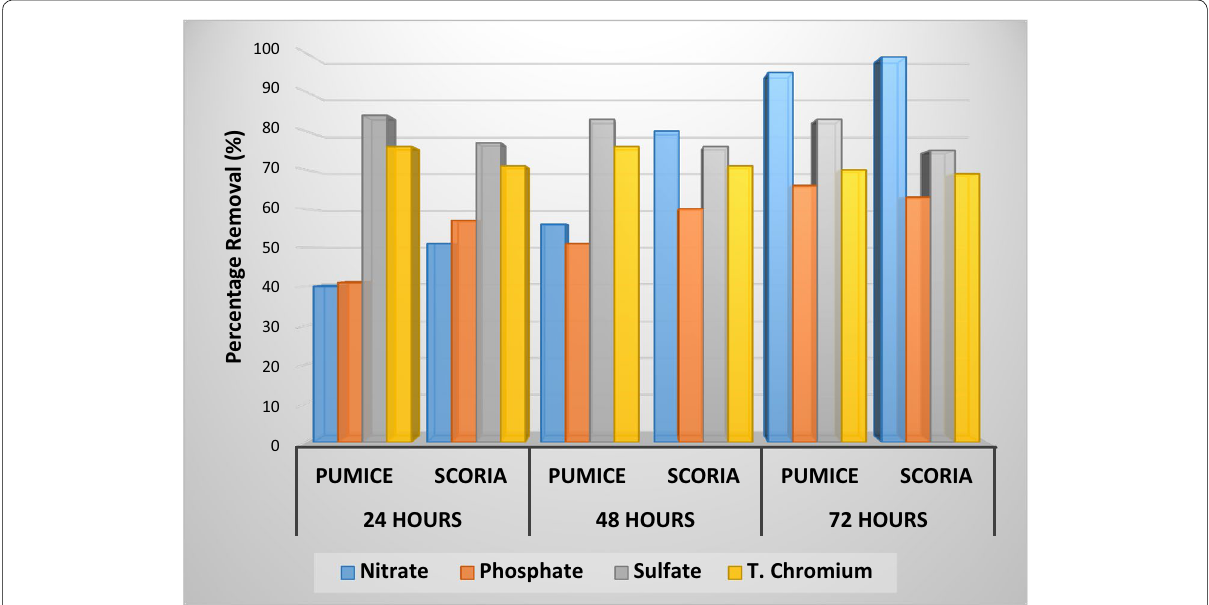
Fig. 9 Comparison of scoria and pumice on the removal efficiency of nutrients, sulfate and